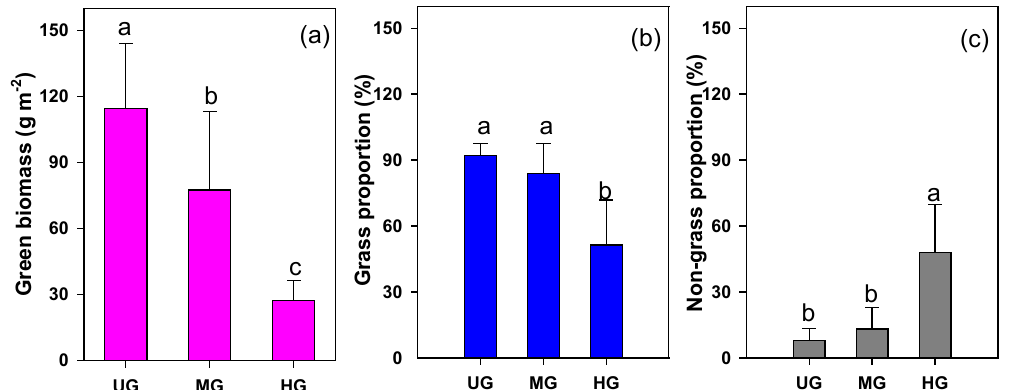
Figure 4. Green biomass (a) , grass composition proportion (b) and non-grass composition proportion (c) at sites exposed to three grazing intensities (UG–ungrazed, MG–moderate grazing, HG–heavy grazing). Bars represent + standard error. Different letters mean significant difference at P< 0.05.